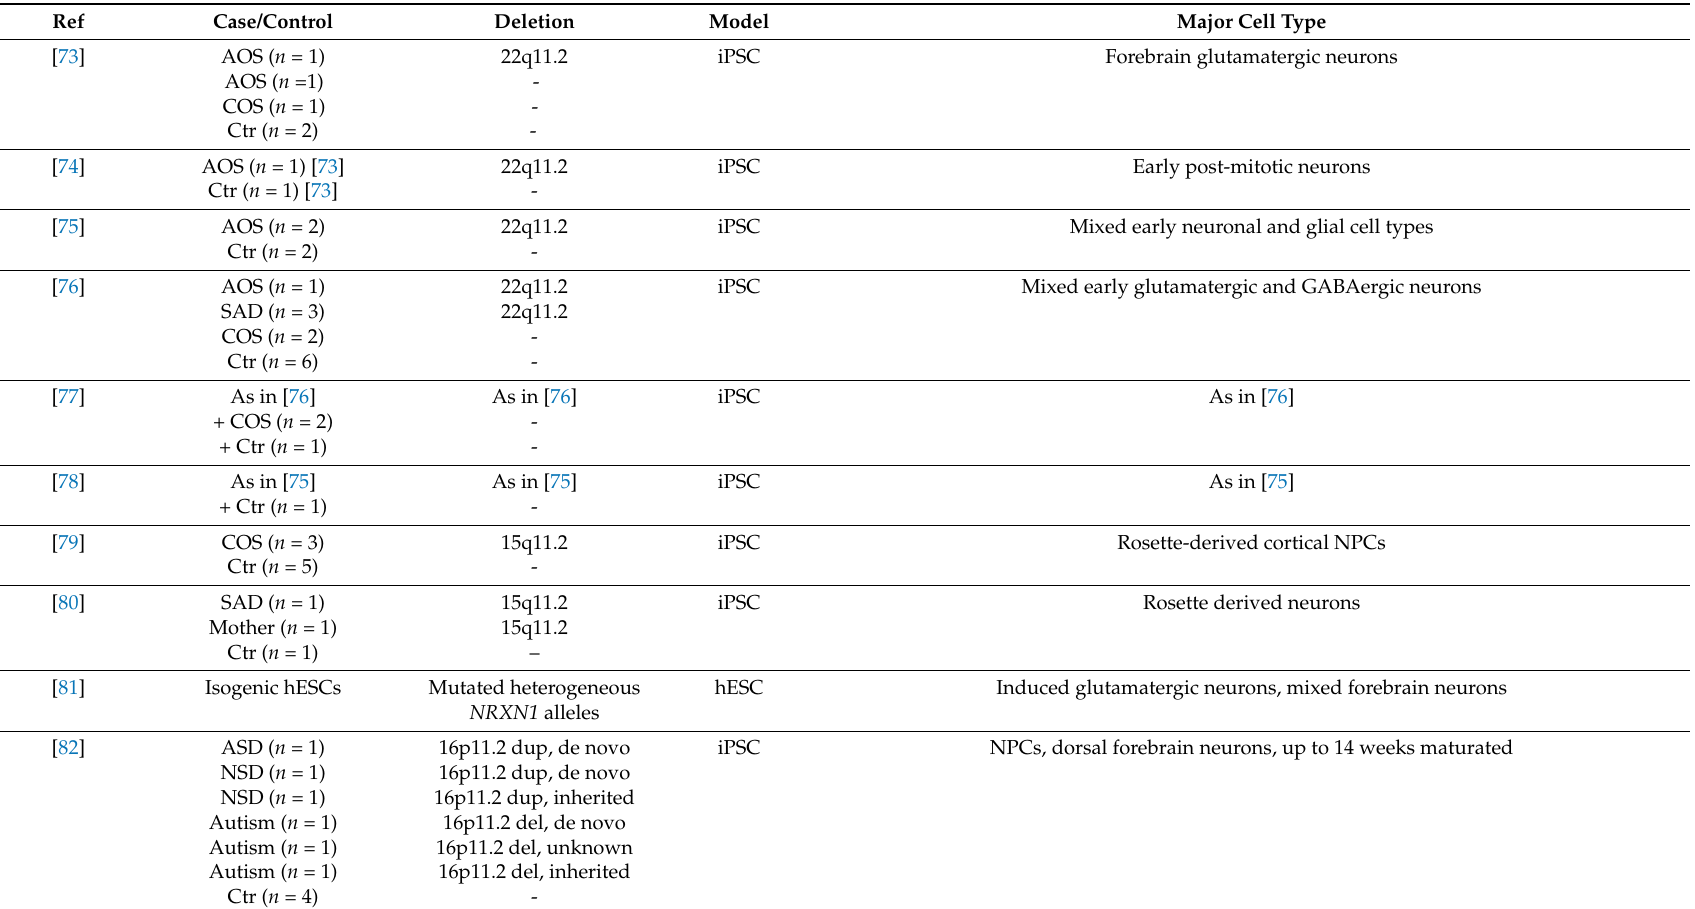
Table 3. Study design, cellular model, and neuronal cell